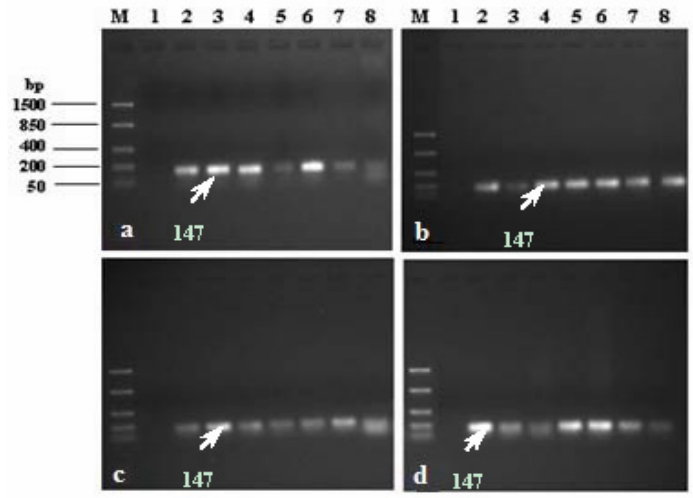
Figure 8. Amplification of uidA gene in E. coli . Lane M: DNA ladder, Lane 1: negative control, Lane 2: positive control: E. coli ATCC 25922 (10 μL), Lane 3: positive control: E. coli ATCC 25922 (5 μL), Lanes 4 to 8: presumptive E. coli colonies 1 to 5 isolated from raw water samples. Presumptive E. coli colonies isolated from ( a ) Apies River, ( b ) Hartbeespoort Dam, ( c ) Delmas borehole, and ( d ) Wallmannsthal